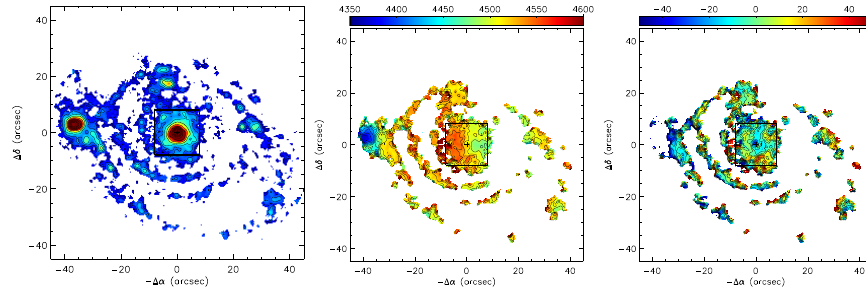
Fig. 5. Mrk 348: the FPI data in H (cid:11) : monochromatic map (left), velocity (cid:12)eld (middle) and the residual velocities (right).